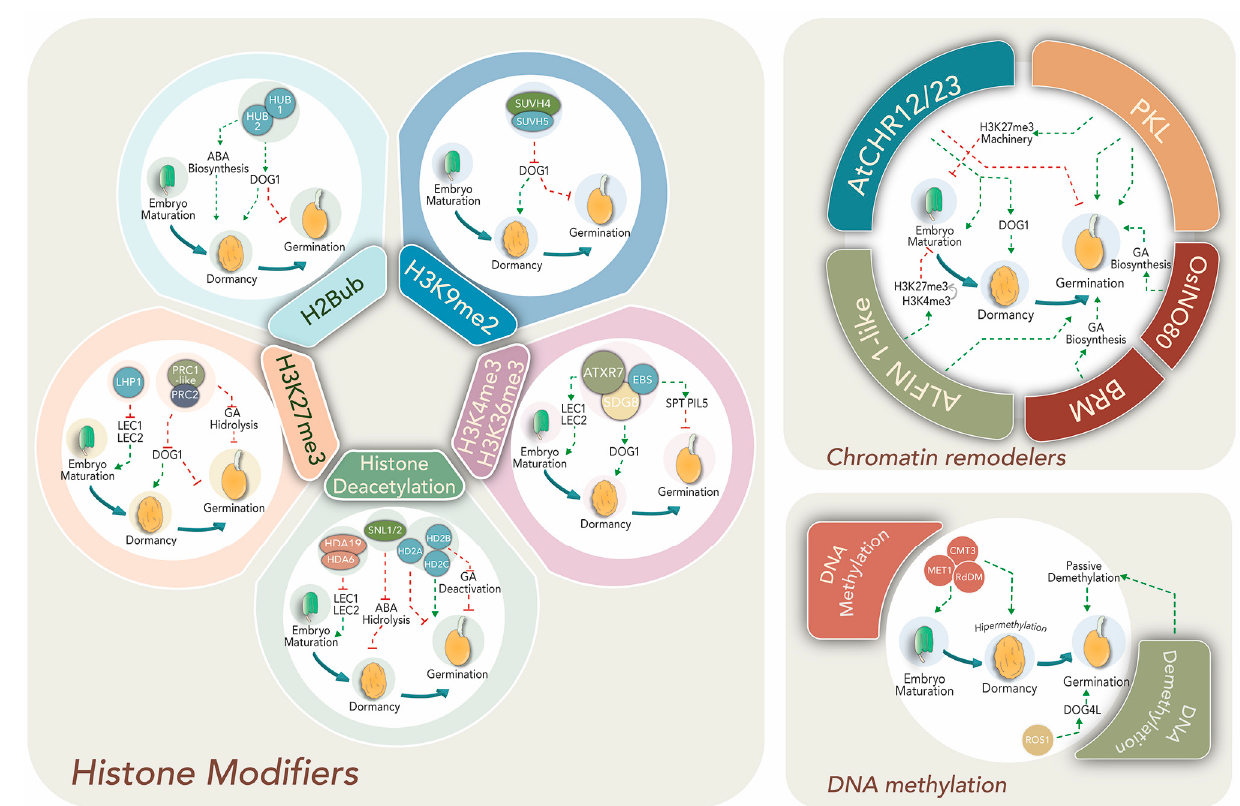
Figure 2. Principal epigenetic modifications and effectors regulate dormancy and germination.